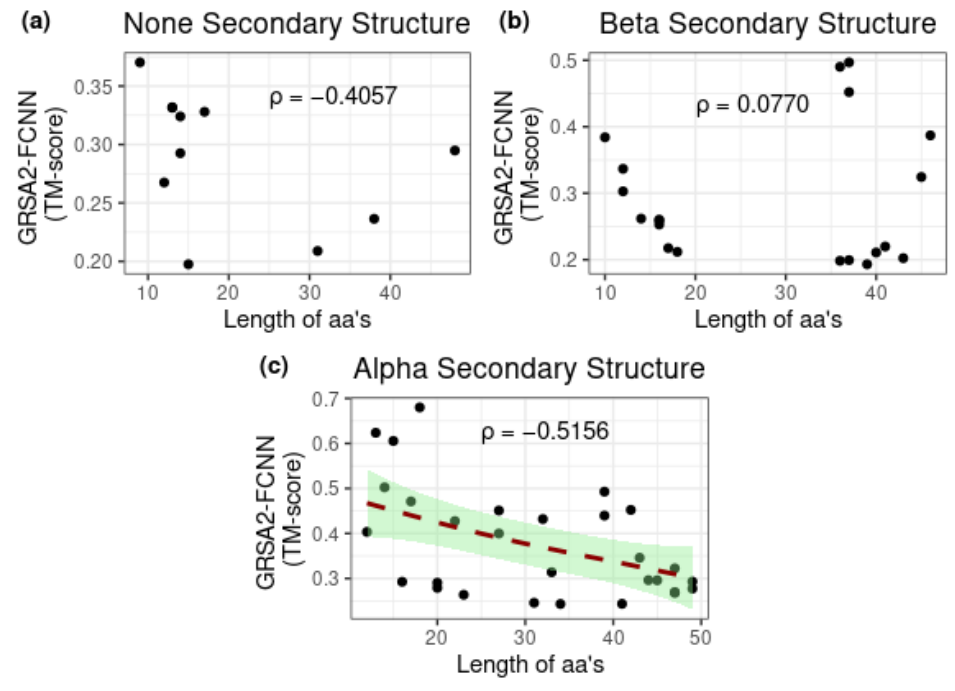
Figure 12. Secondary structure performance versus length of peptides, ( a ) Alpha structures, ( b ) Beta structures, and ( c ) None structures. Table 2. Ranking of algorithms by